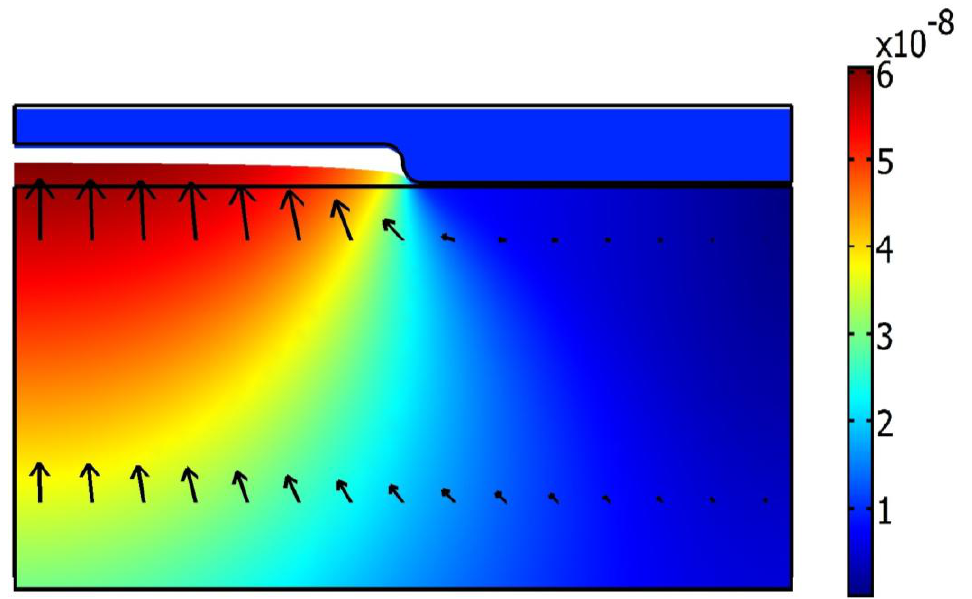
Figure 8. Distribution of total displacements (in meters) after heating